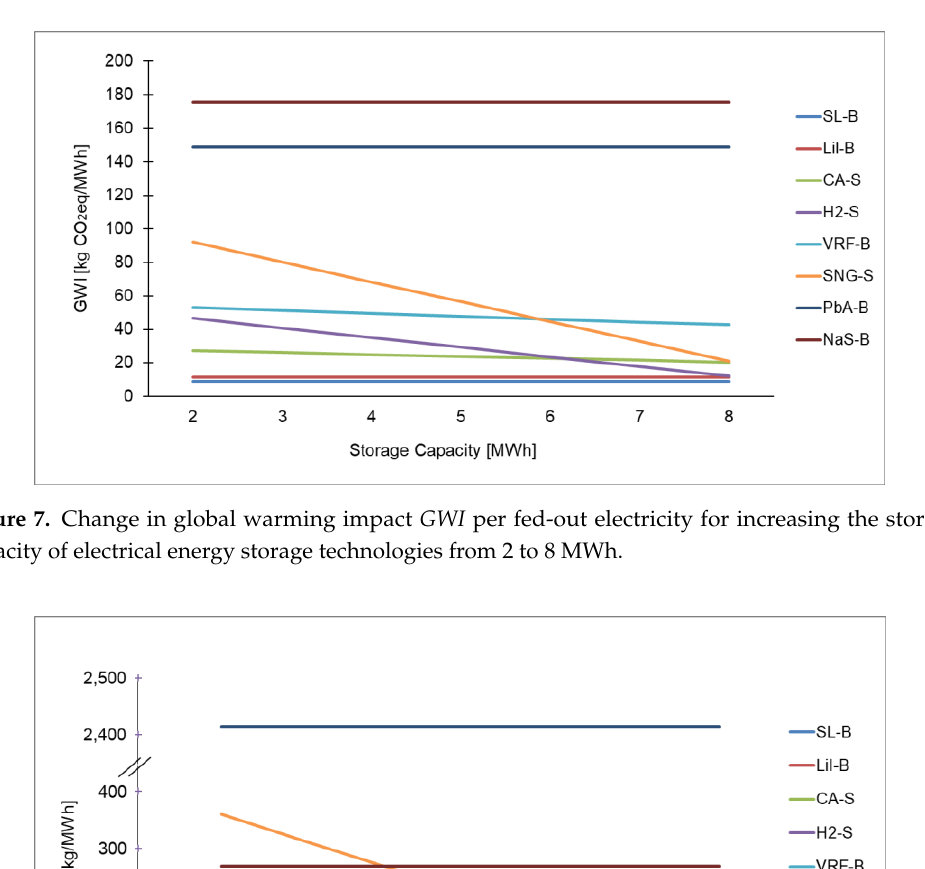
Figure 6. Change in raw material input abiotic RMI abiotic per fed-out electricity for shorter and longer lifetime of electrical energy storage technologies.